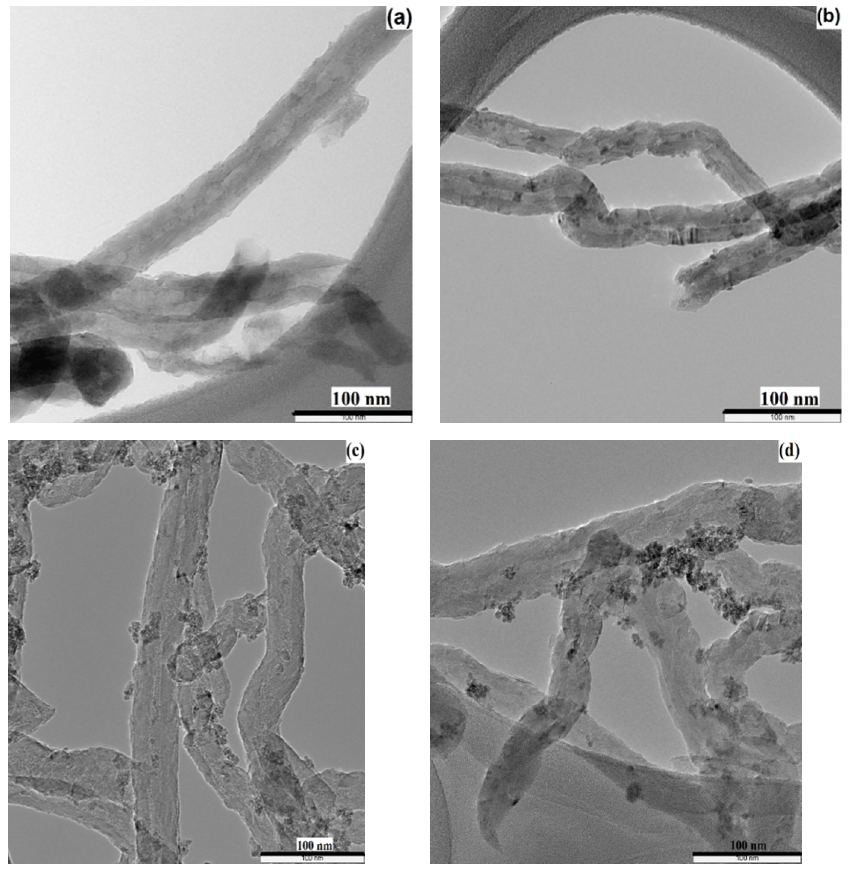
Figure 4. TEM images of ( a ) 95Co5Mn/CNT, ( b ) 90Co10Mn/CNT, ( c ) 85Co15Mn/CNT, ( d ) 80Co20Mn/CNT catalysts.